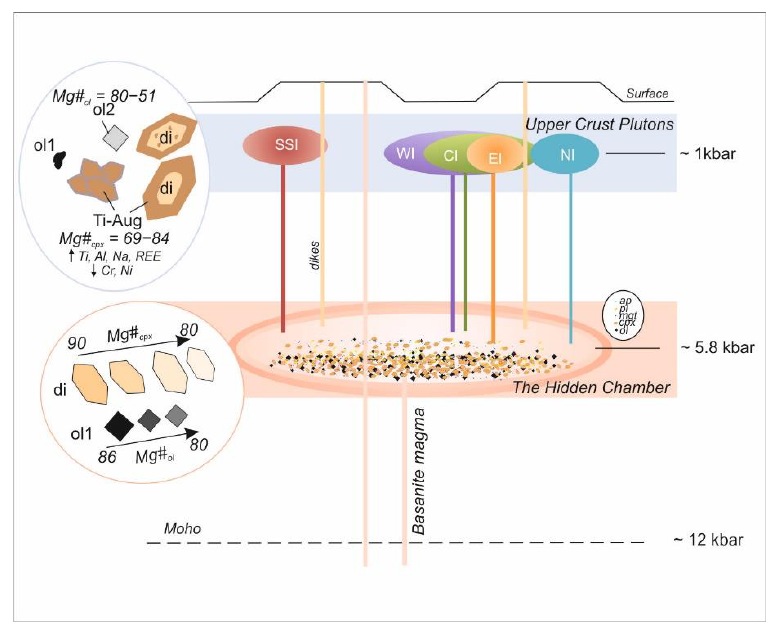
Figure 13. Schematic illustrating the proposed petrological model for the Ponte Nova mafic – ultramafic alkaline massif, outlined as repeated influxes of antecryst-laden basanite magma pulses. The antecryst assemblage is mainly formed by clinopyroxene (cpx), with subordinate olivine (Ol) and minor plagioclase (pl), apatite (ap) and Ti-magnetite (mgt). These minerals are the main cumulus phases found in the lower levels of the main cumulate intrusions of the massif and indicate a deeper hidden chamber for Ponte Nova massif. The ~5.8 kbar P estimation offered are relative to the calculations based on clinopyroxene-melt thermobarometry [66,68]. The dikes shown correspond to basic – ultrabasic dikes from the Mantiqueira Range, presenting similar clinopyroxene and olivine antecryst population. In the upper crust plutons of the Ponte Nova massif, corrosion and/or resorption/re-equilibration of antecrysts are a common feature, with mantled (growth type) by Ti-augite.